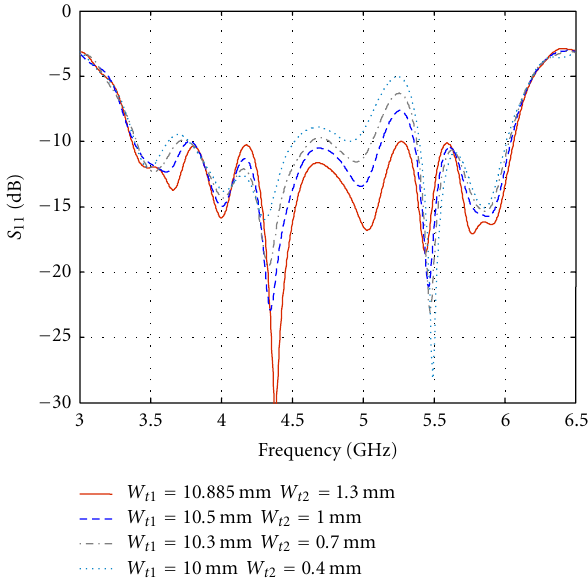
Figure 6: Reflection coe ffi cient of the MSA-BP for di ff erent W t 1 and W